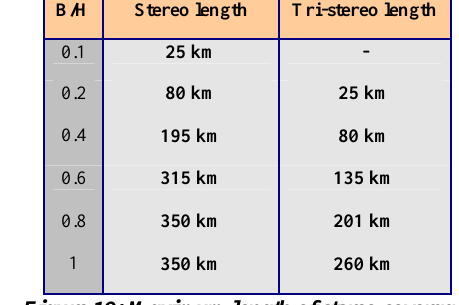
Figure 10: Maximum length of stereo coverage •